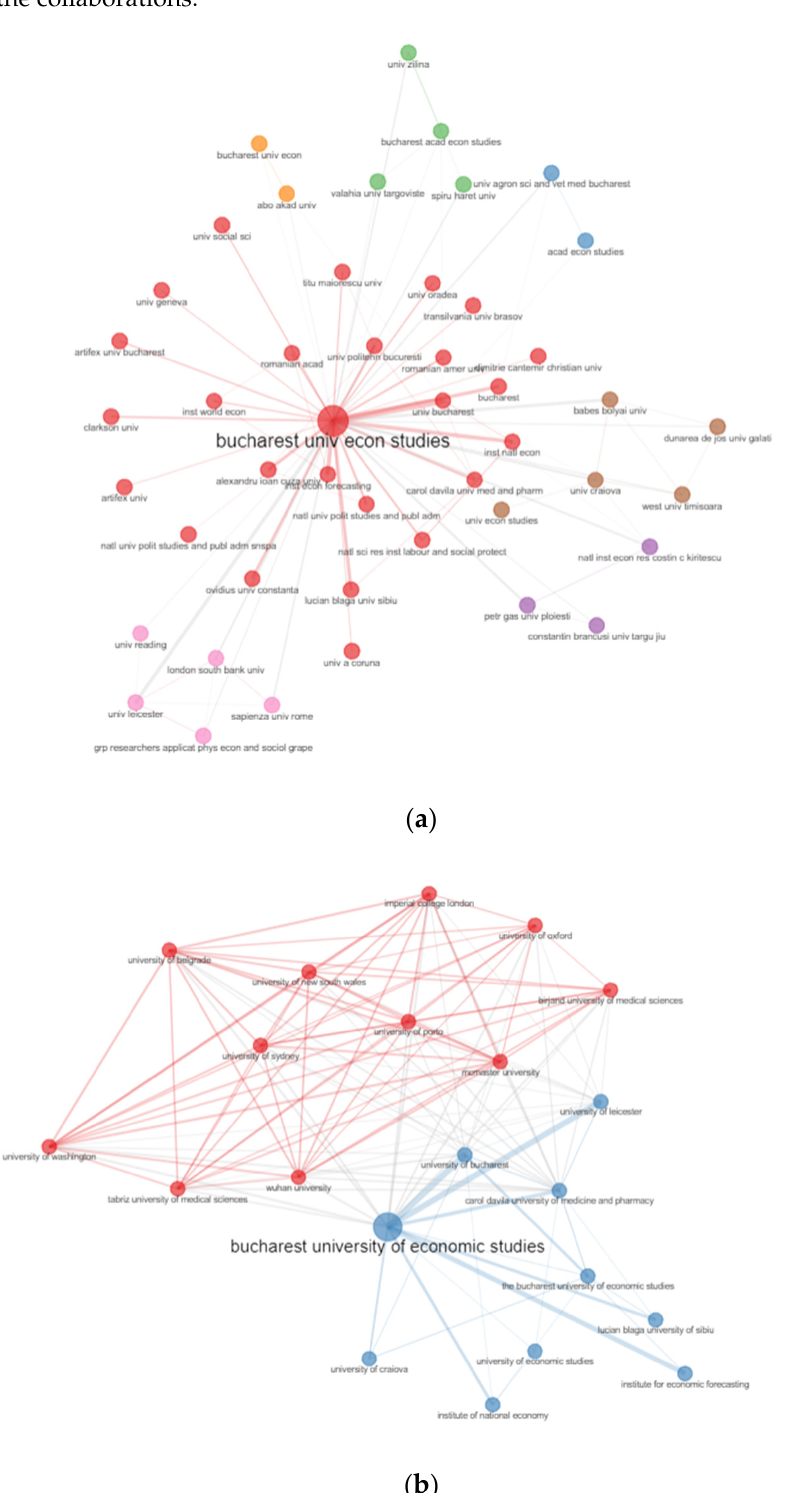
Figure 18. Institution’s collaboration network. ( a ) WoS. ( b ) Scopus.